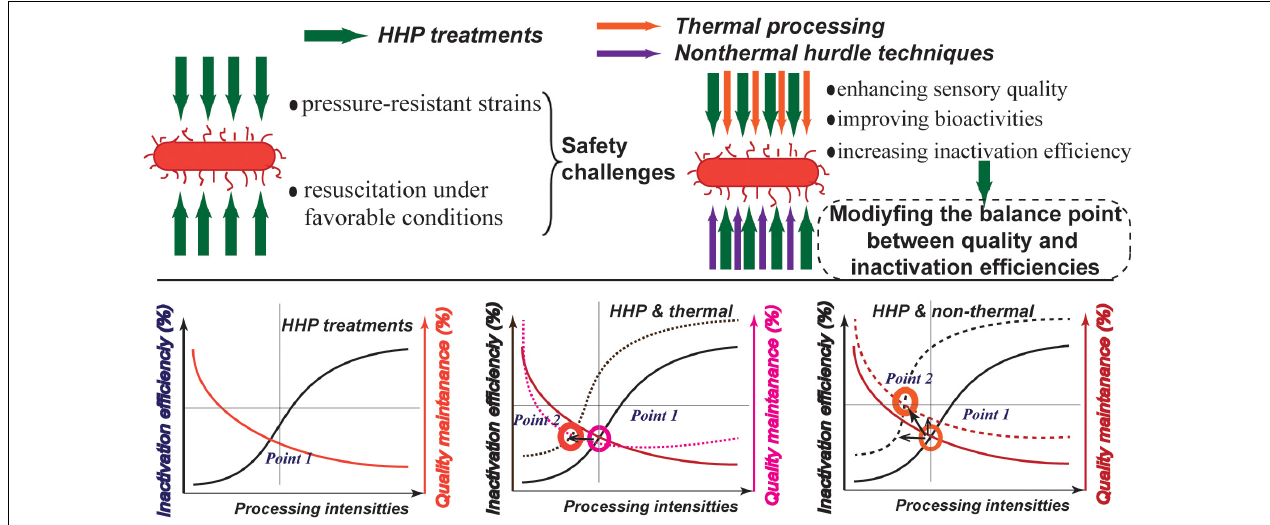
FIGURE 1 | Background for proposing the combination of high hydrostatic pressure (HHP) processing with other hurdle techniques: introduction of HHP-based combination strategies to modify the balance point between quality maintenance and microbial inactivation